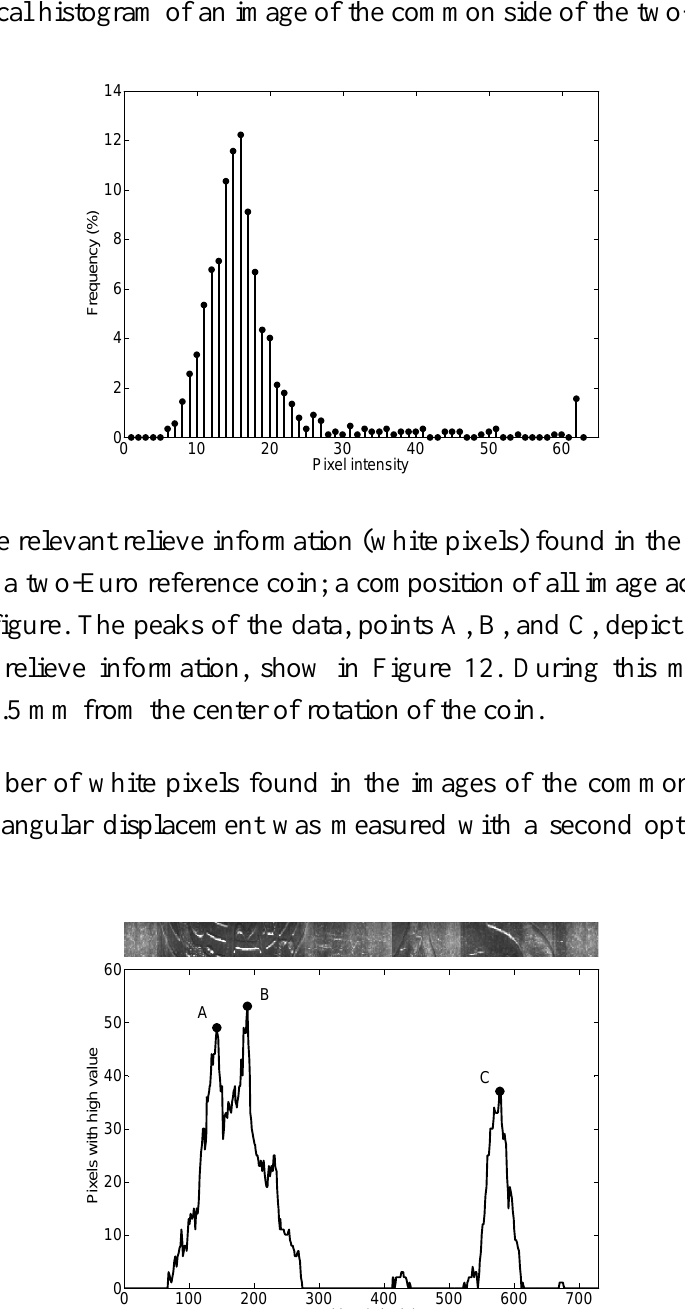
Figure 10. Typical histogram of an image of the common side of the two-Euro coin.